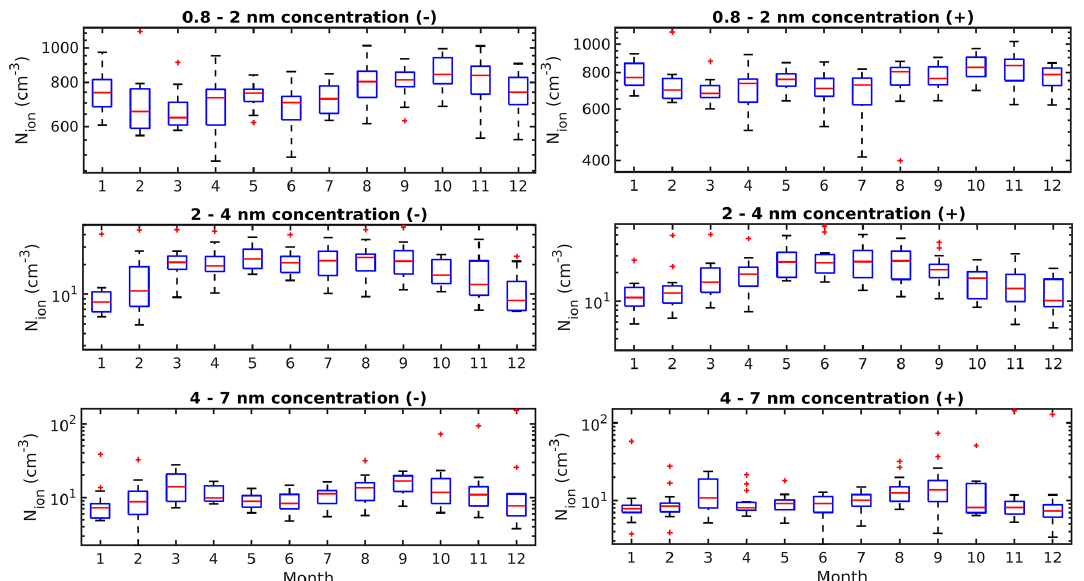
Figure 6. The annual variance of ion concentrations in the size bins 0.8–2, 2–4, and 4–7nm. The left-hand-side box plots are in the negative polarity, and the right-hand-side box plots are in the positive polarity. The numbers on the x axis are month numbers (January–December). The red line is the median concentration, and the blue box contains 50% (25th to 75th percentile) of all data points. The whiskers mark the location of the 95th and 5th percentile data points. The red crosses are outliers.